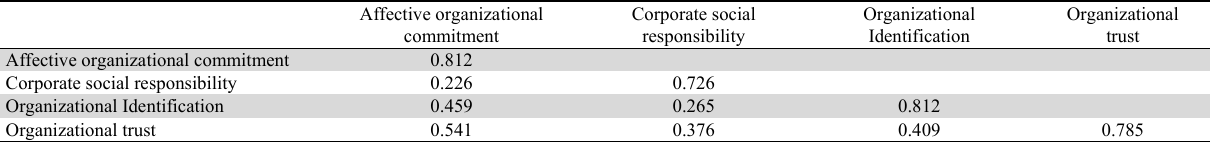
Discriminant Validity (Fornell-Larcker Criterion)